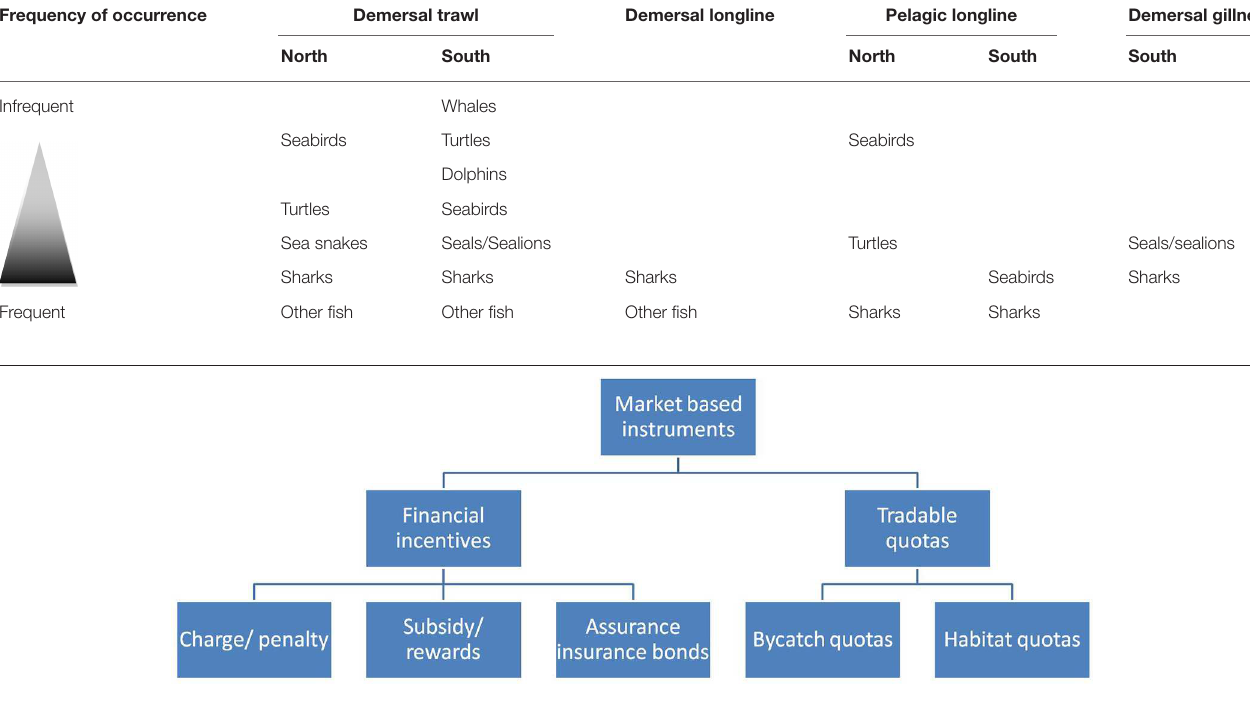
FIGURE 1 | Hierarchy of market-based fisheries management systems for reducing environmental damage.